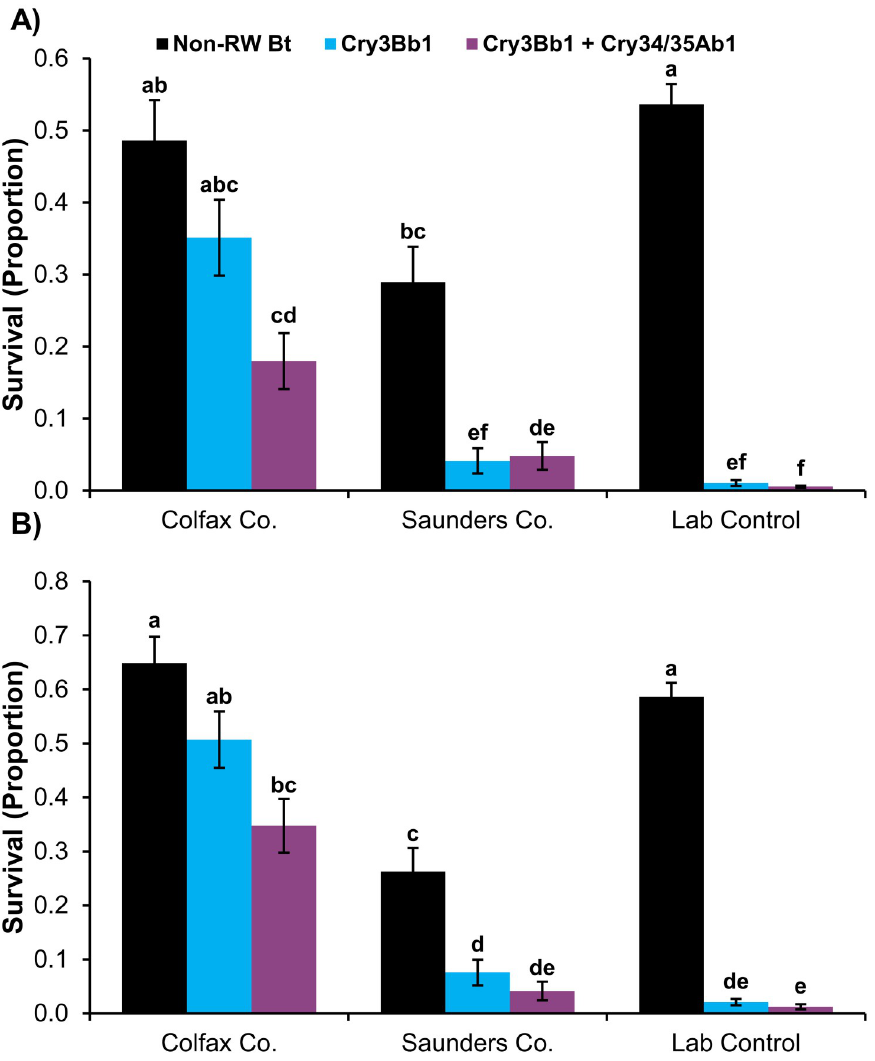
Fig 4. Mean larval survival ( ± SE) of field-collected WCR populations and susceptible lab control colonies used in plant-based bioassays. A) 2019 bioassays and B) 2020 bioassays. Non-RW Bt = non-rootworm active Bt corn; Cry3Bb1 + Cry34/35Ab1 = SmartStax 1 . Bars with the same letter were not significantly different (GLMM, P >